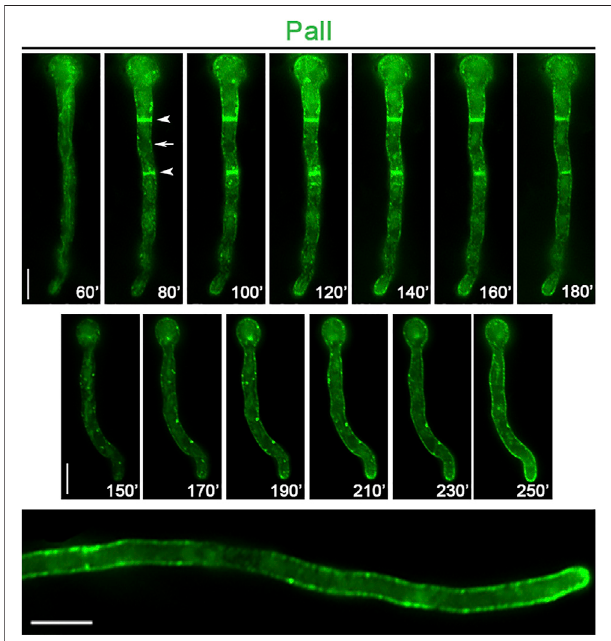
FIGURE 6 | Subcellular localization of neosynthesized PalI. In vivo epi fl uorescence microscopy of de novo -made PalI-GFP observed in two single germlings at various times (60 – 250 min, upper and middle panels) after transcriptional derepression. PalI initially labels a membranous network (best seen at 60 min in the upper panel) and later ER rings and septa (see arrowsintheupperpanel).Noticealsothefrequentappearanceofcytosolicor corticalimmotilefoci(betterdetectedat150 – 230 mininthemiddlepanel).Ina more mature hypha, PalI (360 min) is homogenously localized at the plasma membrane, with still some prominent cortical foci (lower panel). Scale bars: 5 μ m.